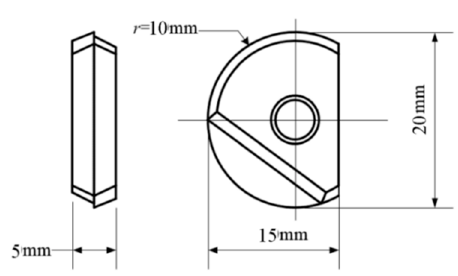
Figure 14. Titanium alloy processing method.